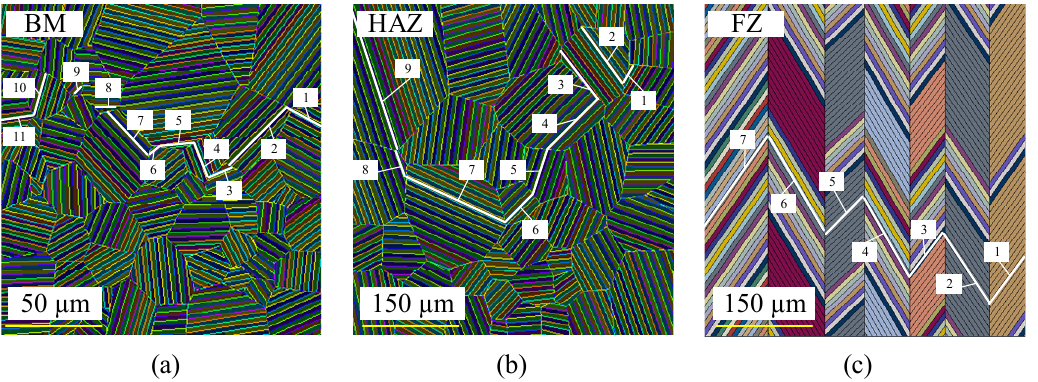
Figure 12. ( a ) Crack expansion path in BM zone. ( b ) Crack expansion path in HAZ. ( c ) Crack expan- sion path in FZ. expansion path in